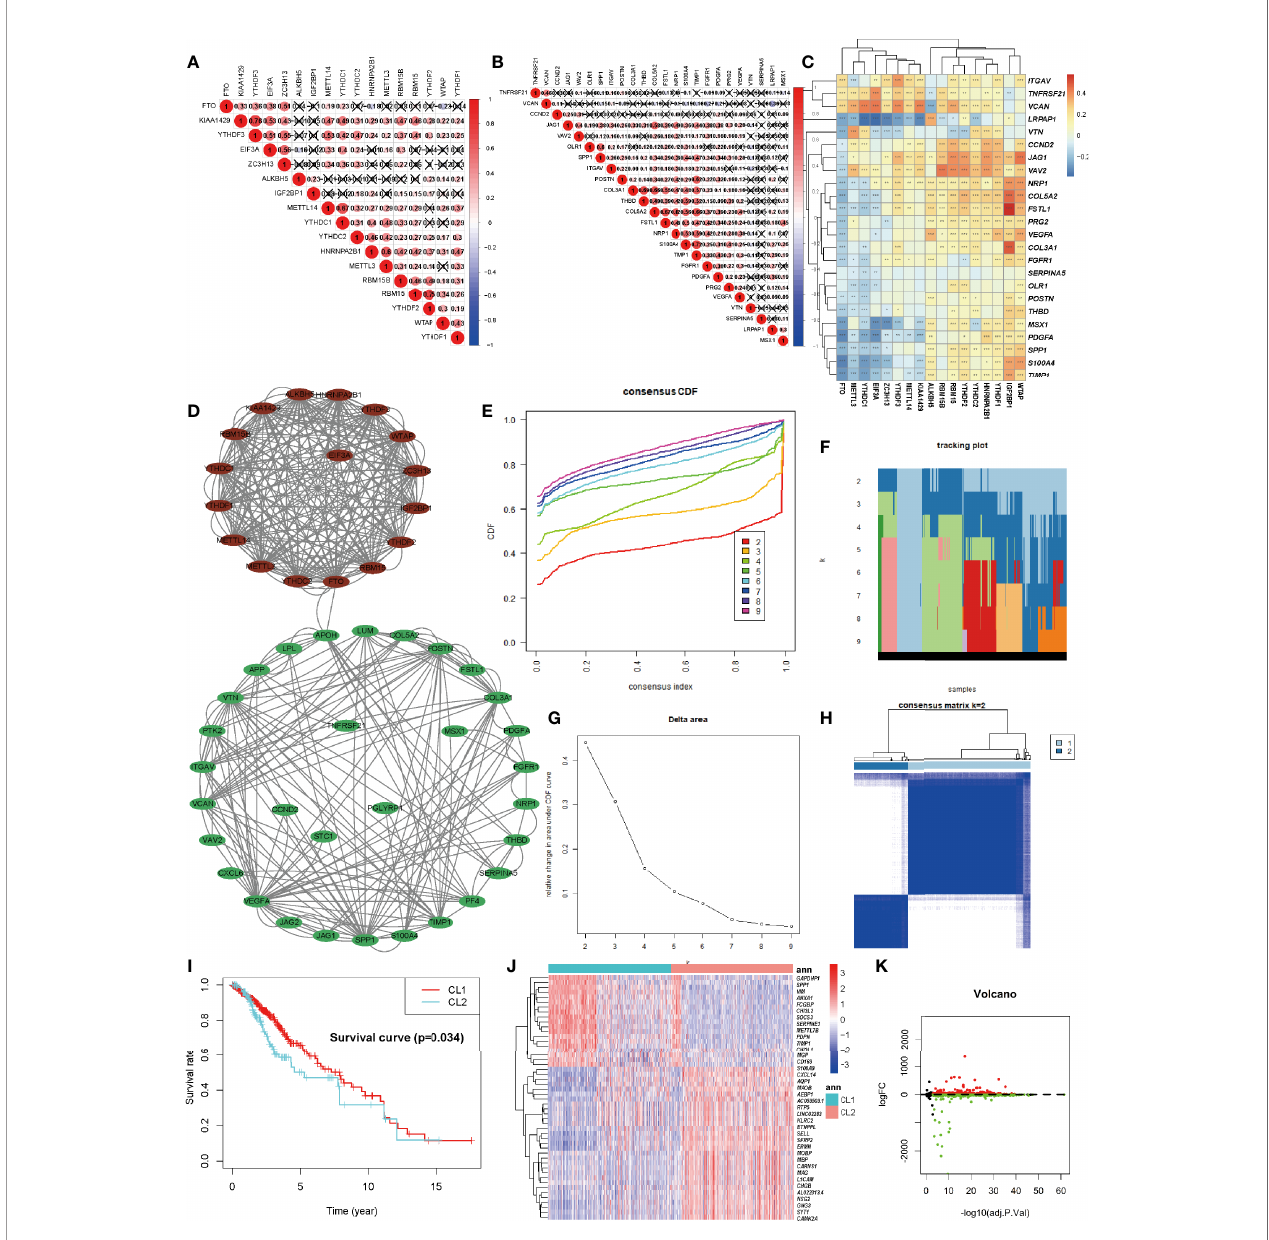
FIGURE 2 | Identi fi cationandFunctionalEnrichmentofTwoClustersofLGG. (A) The m6A modi fi cation-relatedinteractions amongthestudiedm6Aregulators. (B) The angiogenesis-relatedinteractionsamongthestudiedangiogenesis-relatedgenes(ARGs). (C) Thecorrelationsbetweeneachm6Aregulators andthe expressionofeachARGs usingSpearmananalyses. Anegativecorrelationwasmarkedwithblueandpositivecorrelationwithred. (D) Theprotein-proteininteractionbetweenARGsandm6A regulators (MAGs).Thedenseness ofconnectionlinesrepresentedtheconnectionstrengthofeachnode. ARGswere labeledasgreendotsinthecircleandm6Aregulatorswerelabeledas reddots inthecircle. (E) Consensusclustering cumulativedistributionfunction(CDF) fork=2-10inTCGA-LGGcohort. (F) Relative changeintrackingplotunder theCDFcurve fork= 2-10 intheTCGA-LGG cohort. (G) Relativechangeinareaunder the CDFcurvefork= 2-10 intheTCGA-LGG cohort. (H) Consensus clusteringmatrix for k=2 inthe TCGA-LGGcohort. (I) Kaplan-Meiercurvesfortworobustclusters inthelog-ranktest. (J, K) Heatmap (J) andvolcanomap (K) ofdifferentialexpressedgenesbetween dichotomouslayersbasedonunsupervisedclustering.Theasterisks representedthestatisticalP-value ∗ P <0.05; ∗∗ P <0.01; ∗∗∗